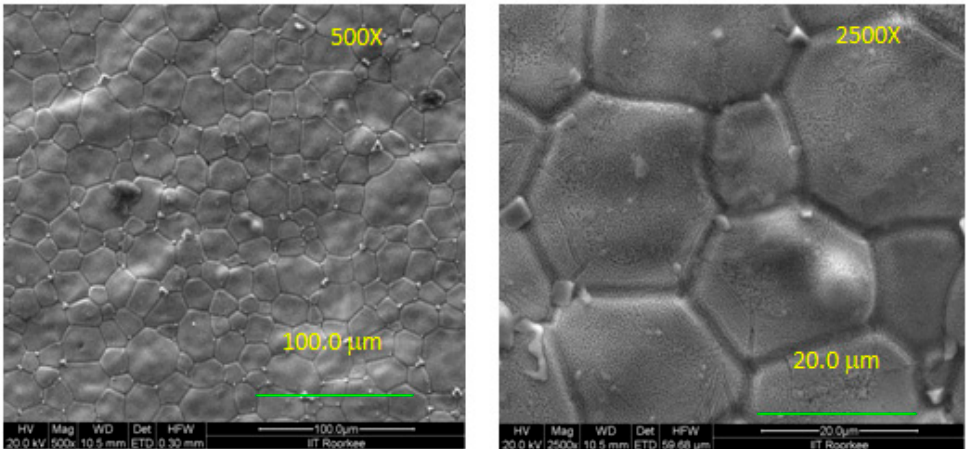
Figure 5. Twelve mol% CaO stabilised zirconia SEM and EDS.